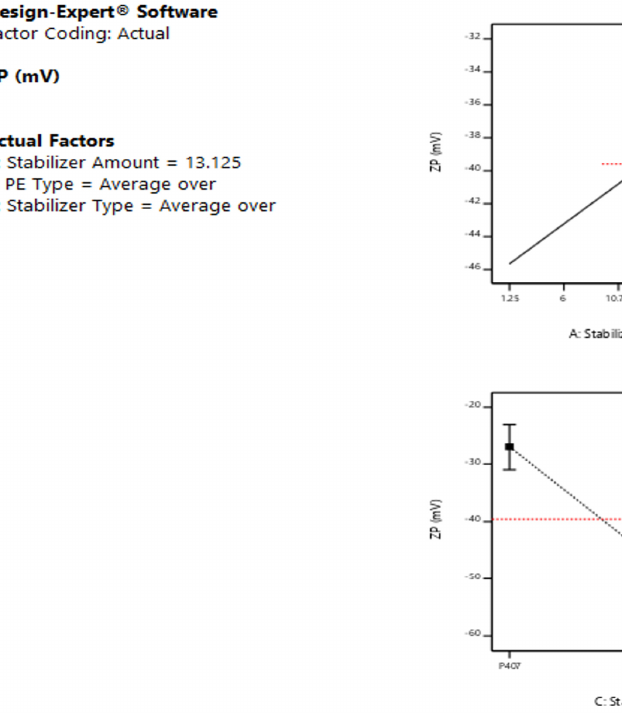
Figure 3. Main e ff ect plots showing the e ff ect of the independent variables; ( A ) stabilizer amount, ( B ) PE type, and ( C ) stabilizer type on the ZP of the prepared LCNs. ( B ) PE type, and ( C ) stabilizer type on the ZP of the prepared